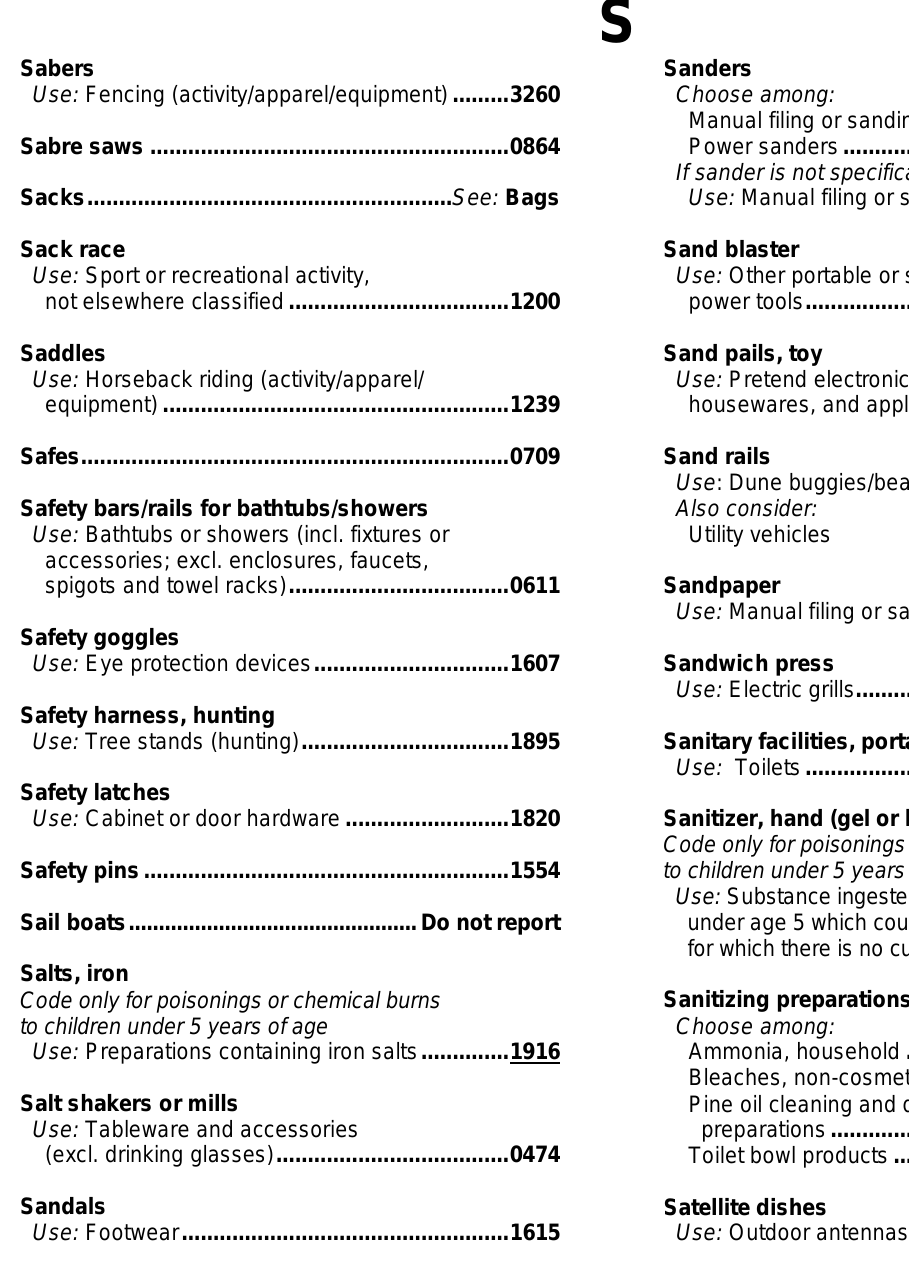
Sack race Use: Sport or recreational activity, Saddles Use: Horseback riding (activity/apparel/